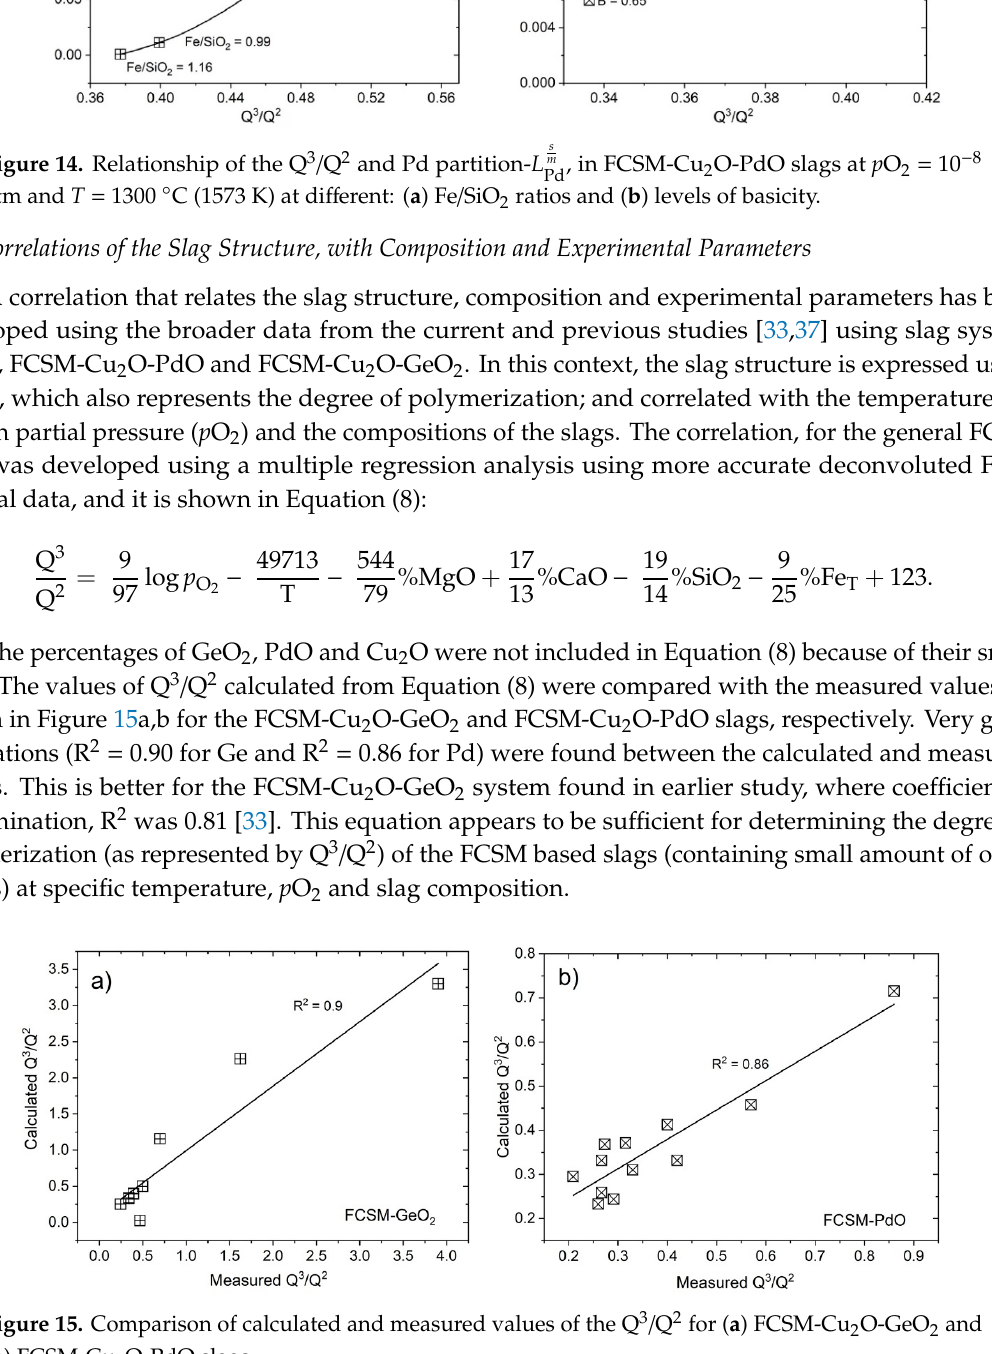
(cid:2900)(cid:2914)(cid:2929) (cid:2923)⁄ s , in FCSM-Cu 2 O-PdO slags at p O 2 = 10 − 8 atm Figure 14. Relationship of the Q 3 / Q 2 and Pd partition- L m , in FCSM-Cu 2 O-PdO slags at p O 2 = 10 − 8 Pd